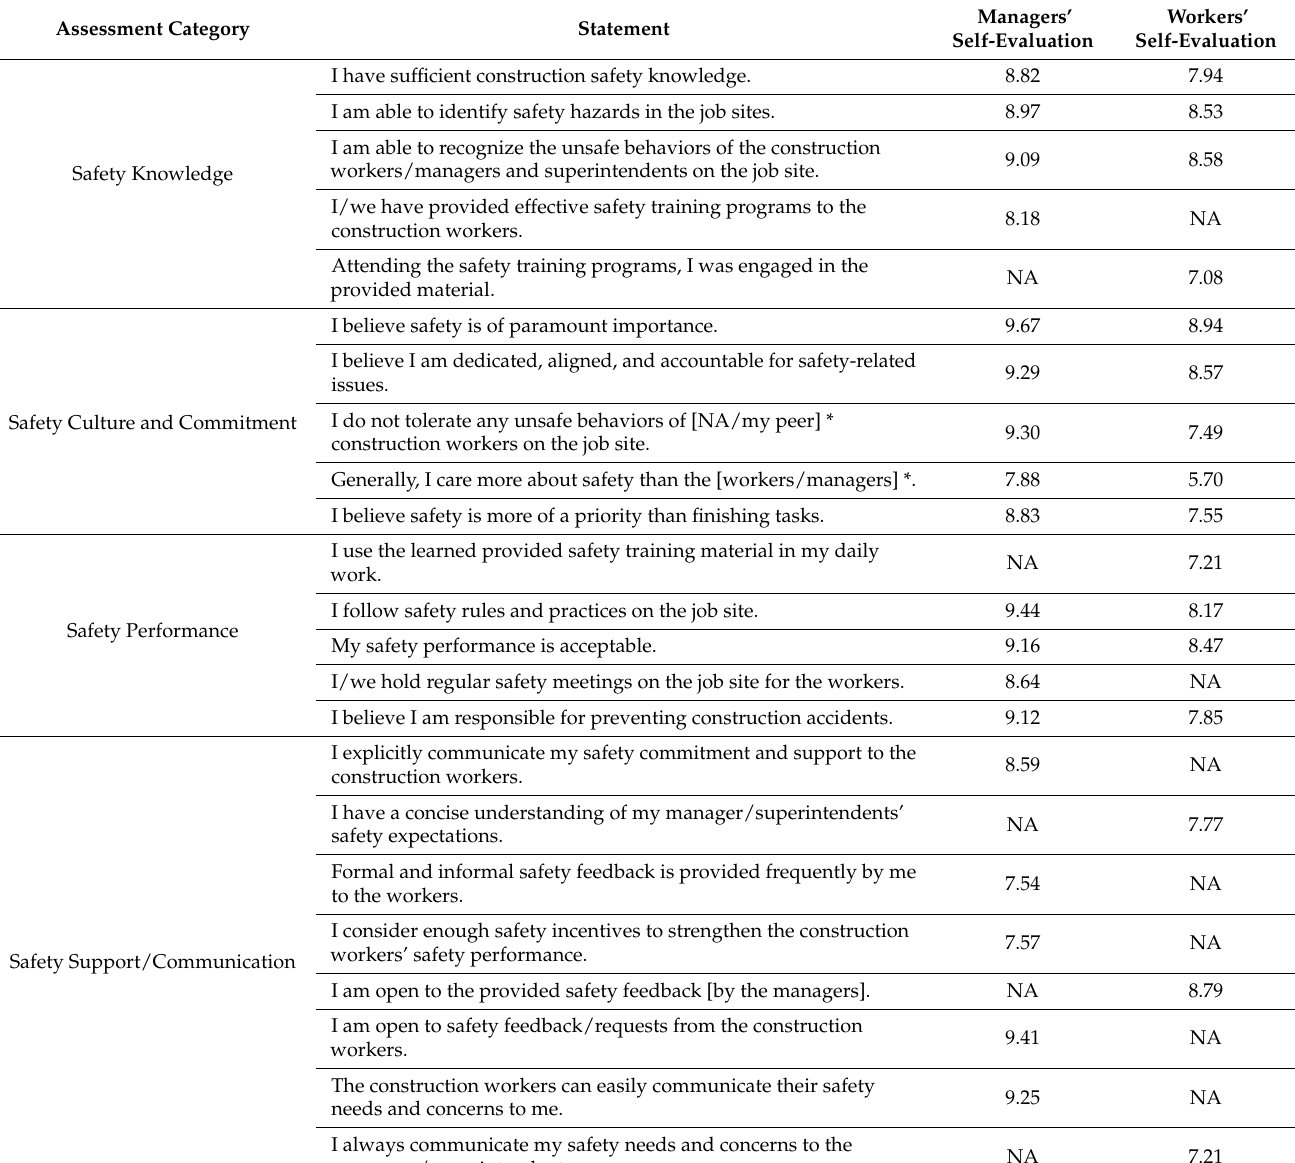
Table 4. Results of self-evaluation of safety perception for construction managers and